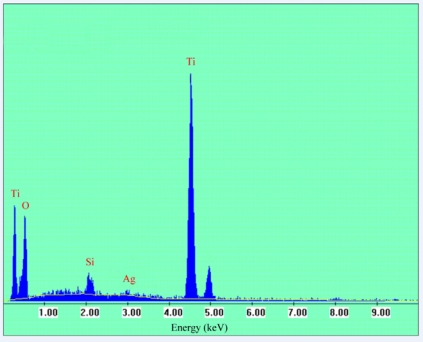
EDX diagram of 2.0 wt% Ag/TiO2 catalyst.